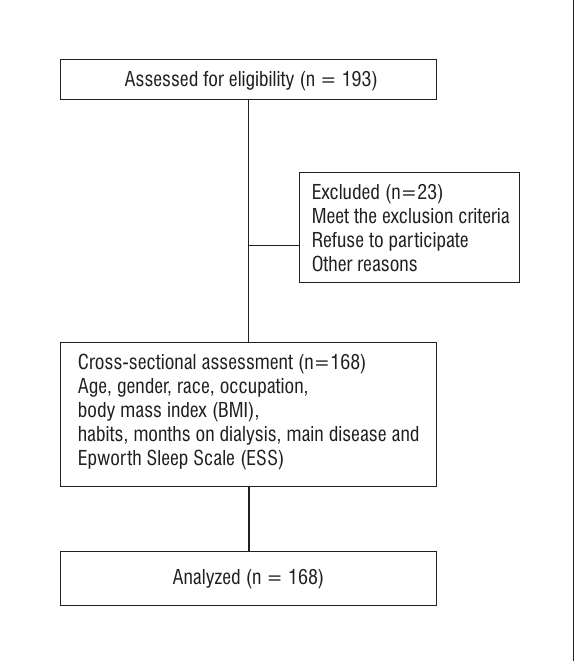
Figure 1 - Flowchart of the